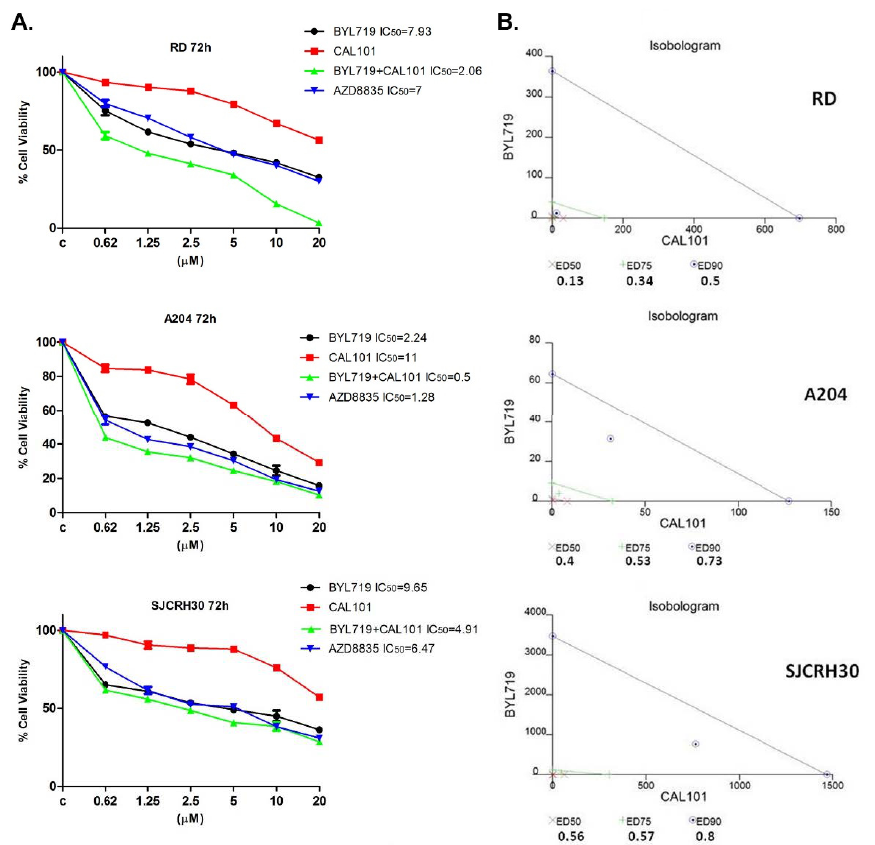
Figure 3. Synergistic effect of BYL-719 + CAL-101 in reducing rhabdomyosarcoma cell viability. ( A ) MTT assay in RD, A204 and SJCRH30 cells treated with BYL-719, CAL-101, BYL-719 + CAL-101, and AZD8835 for 72 h. Cells were seeded in 96-well plates and treated in triplicate with increasing concentrations of inhibitors. After 72 h, a cell proliferation assay was carried-out and the absorbance intensity measured in a microplate reader. Data are representative of three independent experiments. ( B ) Isobologram for combination index (CI) calculations from combined treatment with BYL-719 and CAL-101 for 72 h. The lines link the corresponding concentrations of the two drugs which singularly determine the affected fraction (ED90, ED75, ED50). For each fraction, the corresponding values of CI are reported, with the relative position in the graph (x, +, ⨀ ).